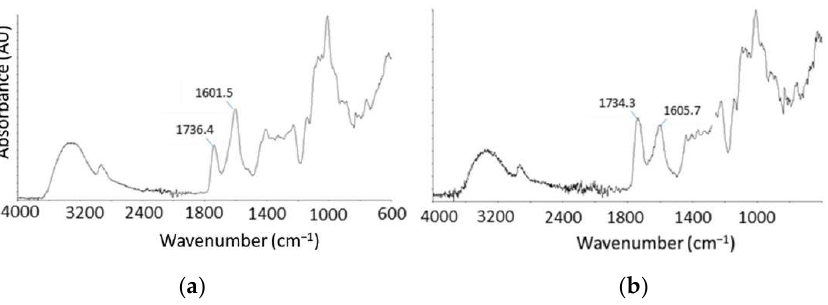
Figure 3. ATR-IR spectra of pectin samples. ( a ): pectin from citrus peel (LM). ( b ): pectin from apple (HM). The band at ca. 1601 cm −1 is due to the symmetrical stretching vibration of carboxylate moiety, whereas the band at ca. 1740 cm −1 is assigned to stretching of carbonyl groups from both carboxylic acid and methyl ester moieties. Considering that at pH 6 in partially methoxylated pectin the carboxylic groups were completely deprotonated, the 1740 cm −1 band can be attributed exclusively to the carboxymethyl groups. The ratio between the absorbance intensity at 1740 cm −1 divided by the sum of those at 1601 and 1740 cm −1 is proportional to DE. The equation reported by Manrique et al. [25] that correlates the DE to absorbance parameters was used for DE determination of the pectins. According to this method, a degree of esterification of 59.3% was determined for citrus peel pectin (LM), whereas a degree of esterification of 70.9% (HM) was assessed for apple-based pectin.